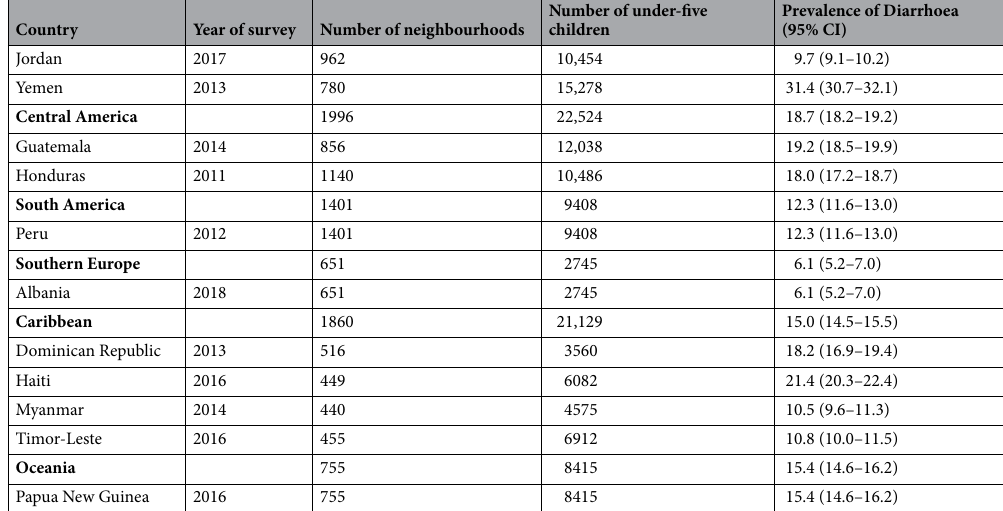
Table 1. Description of Demographic and Health Surveys data by countries and diarrhoea prevalence among under-five children in LMIC,